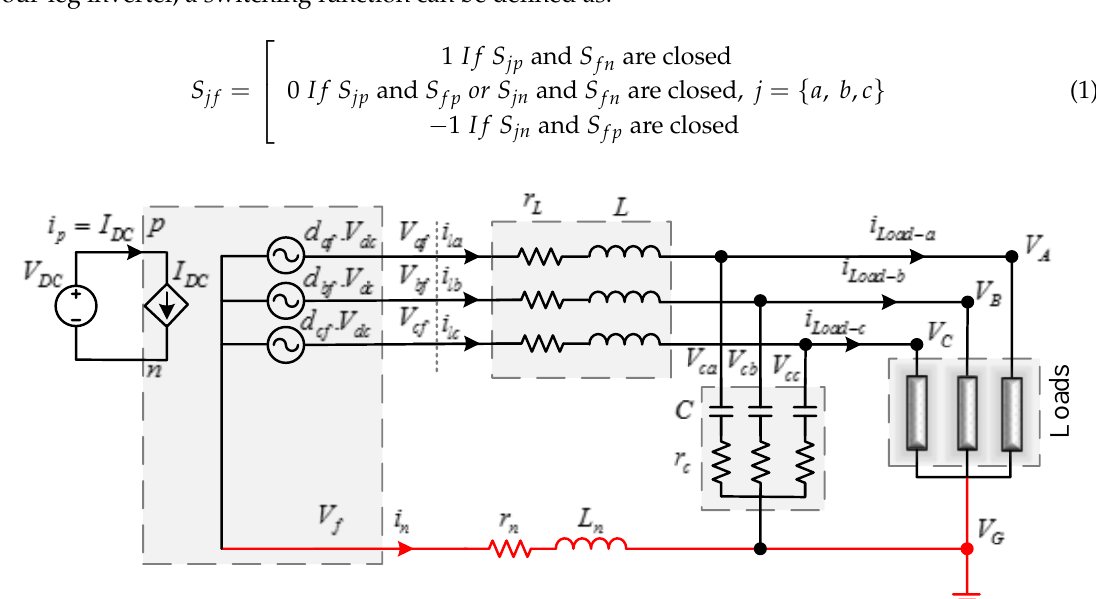
Figure 2. Average large-signal model of the four-leg inverter.